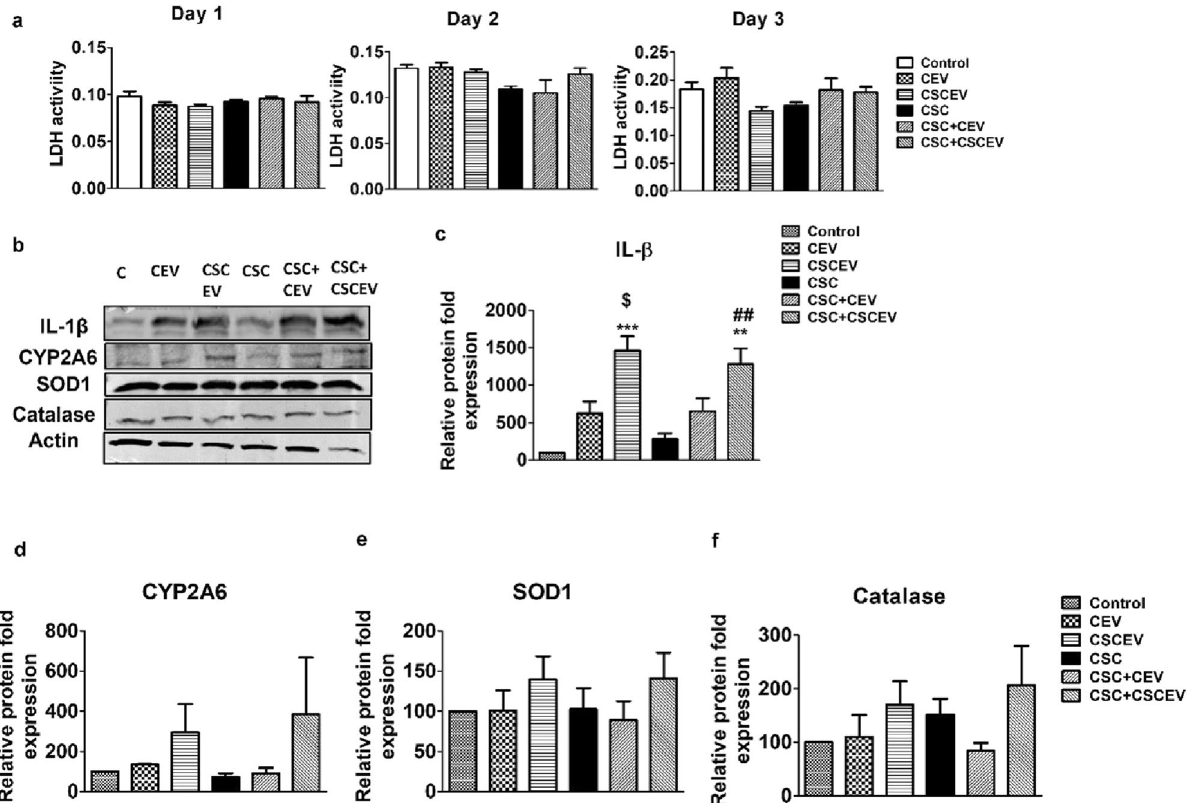
Figure 5. Effect of EVs derived from HIV-infected U1 macrophages on cytotoxicity and levels of IL-1β, CYP2A6, and AOEs in SVGA cells. The SVGA cells (0.1 million cells/well/12well plate) were treated with EVs-derived from control (DMSO) and CSC-exposed (10 µg/ml/day for 7 days) U1-macrophages once daily for 3 days in the presence and absence of CSC (10 µg/ml/day). After 3 days of treatments, LDH levels were measured ( a ). Western blot was performed with an equal amount of protein loaded (5 µg of protein) to measure the protein expression of IL-1β (b&c), CYP2A6 ( b & d ), and antioxidant enzymes (SOD1 and Catalase) ( b , e & f )). One way ANOVA with Tukey’s multiple comparison test was used to find the significance among the groups. CEV represents EVs isolated from the control group; CSCEV represents EVs isolated from the CSC-treatment group. *, **and *** represent p < 0.05, p ≤ 0.01, and p ≤ 0.001 respectively when compared to control; #, ##and ### rep-resents p < 0.05, p ≤ 0.01, and p ≤ 0.001 respectively when compared to